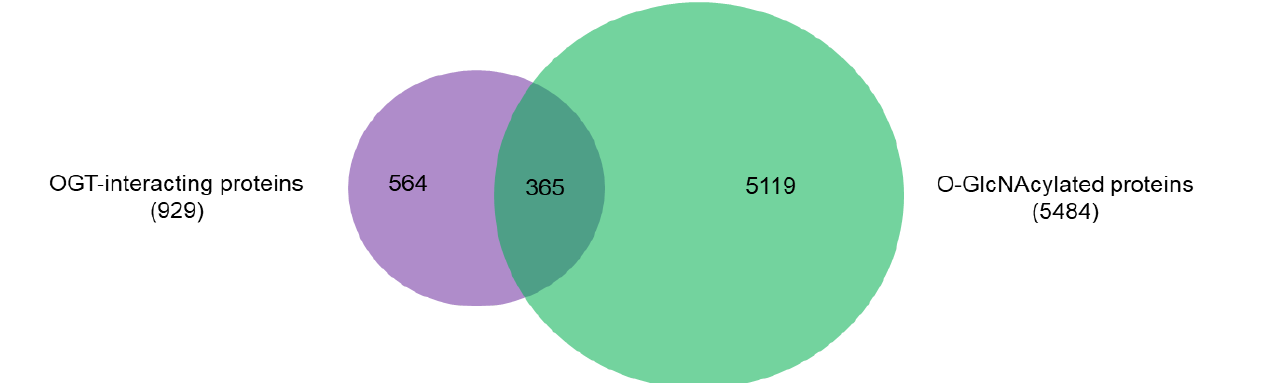
Figure 5. Overlap between 929 high-stringency OGT-interacting proteins in OGT-PIN and O-GlcNAcylated proteins in O-GlcNAcAtlas (Version_01.08).